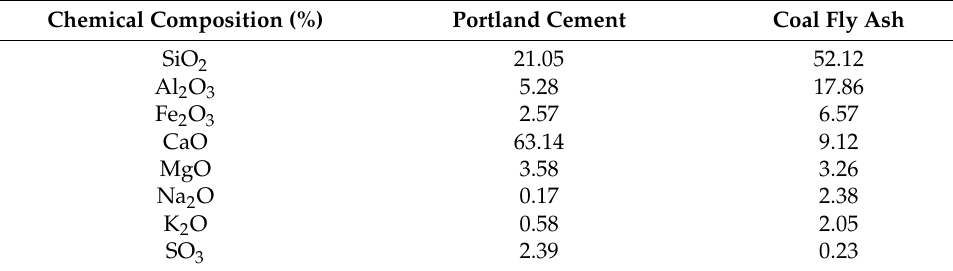
Table 3. Composition of cement and coal fly